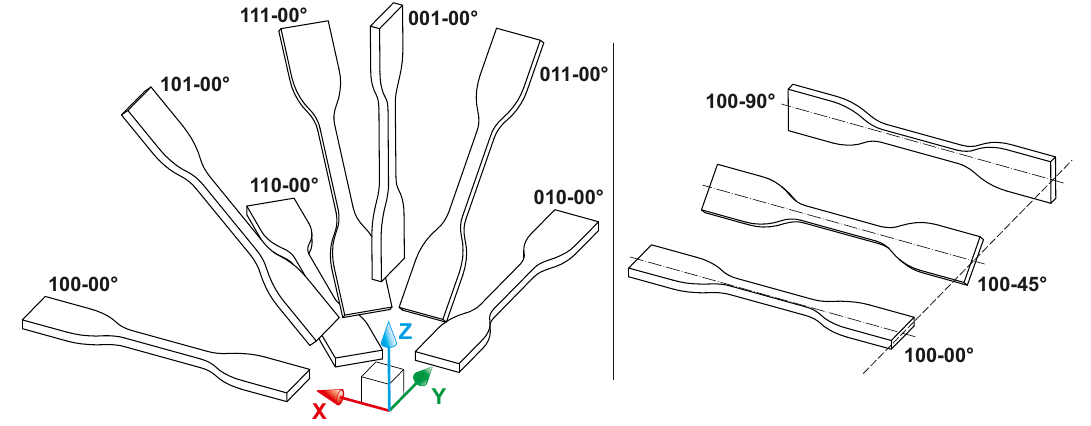
Figure 7. Position of individual specimens.